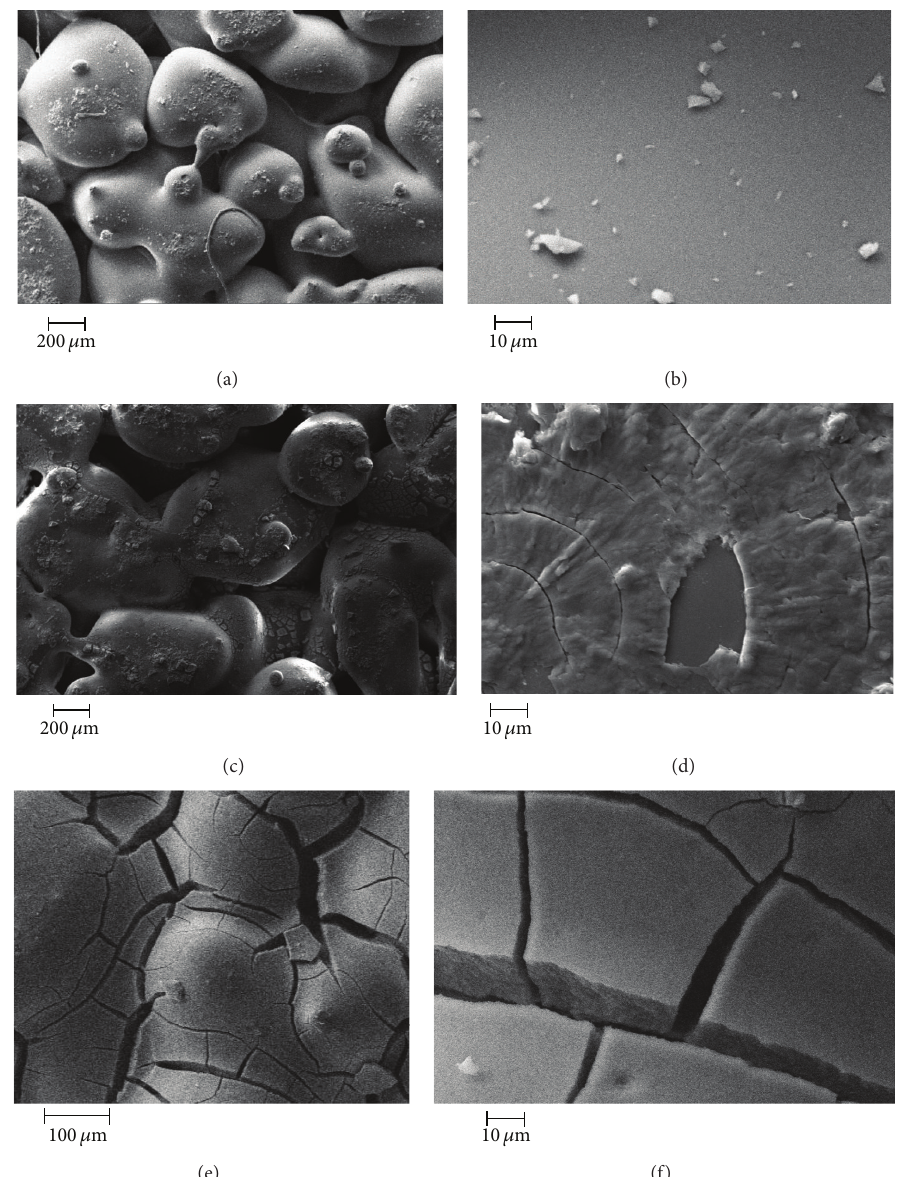
Figure 4: SEM images for uncoated borosilicate sintered glass ((a) and (b)), TiO 2 (TiOSO 4 30,6 wt%) coating on borosilicate glass ((c) and (d)), (e) TiO 2 -P25-SiO 2 , (f) TiO 2 -P25-SiO 2